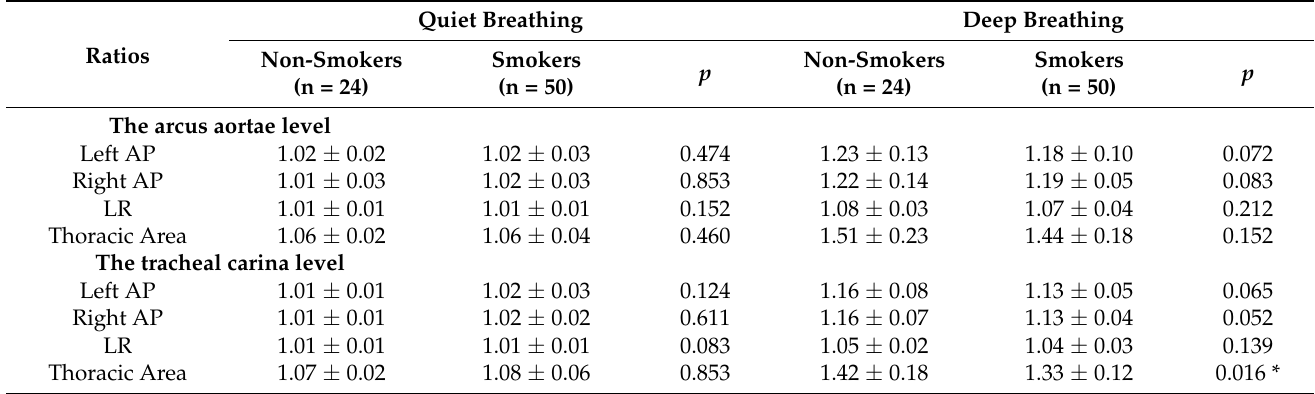
Table 4. The correlation of chest wall and diaphragmatic motion with